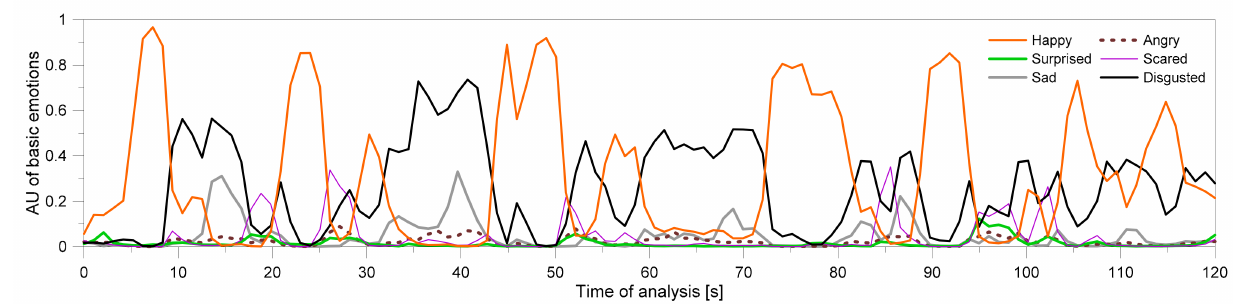
Figure 8. Example of AU records of basic emotional states, as obtained for one of the invited participants exposed to the shared VR input